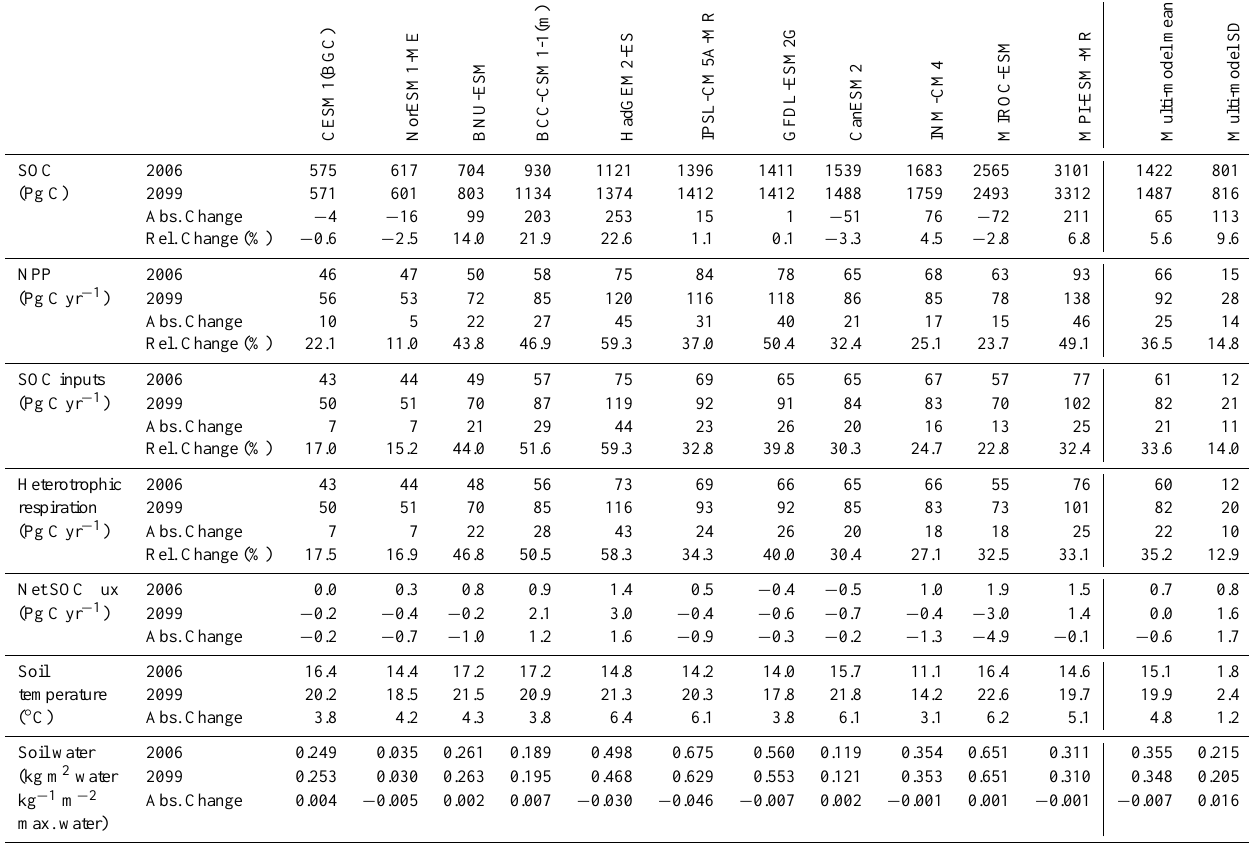
Table 2. Starting value (1997–2006 mean), final value (2090–2099 mean), absolute change, and relative change of soil carbon, net primary productivity (NPP), soil inputs, heterotrophic respiration, net SOC flux (positive values are carbon gains by the SOC pool, negative values are carbon losses), area-weighted soil temperature, and area-weighted normalized soil water content. Soil water is mean gridded soil water content divided by the grid maximum soil water content at the 10-year initial historical mean